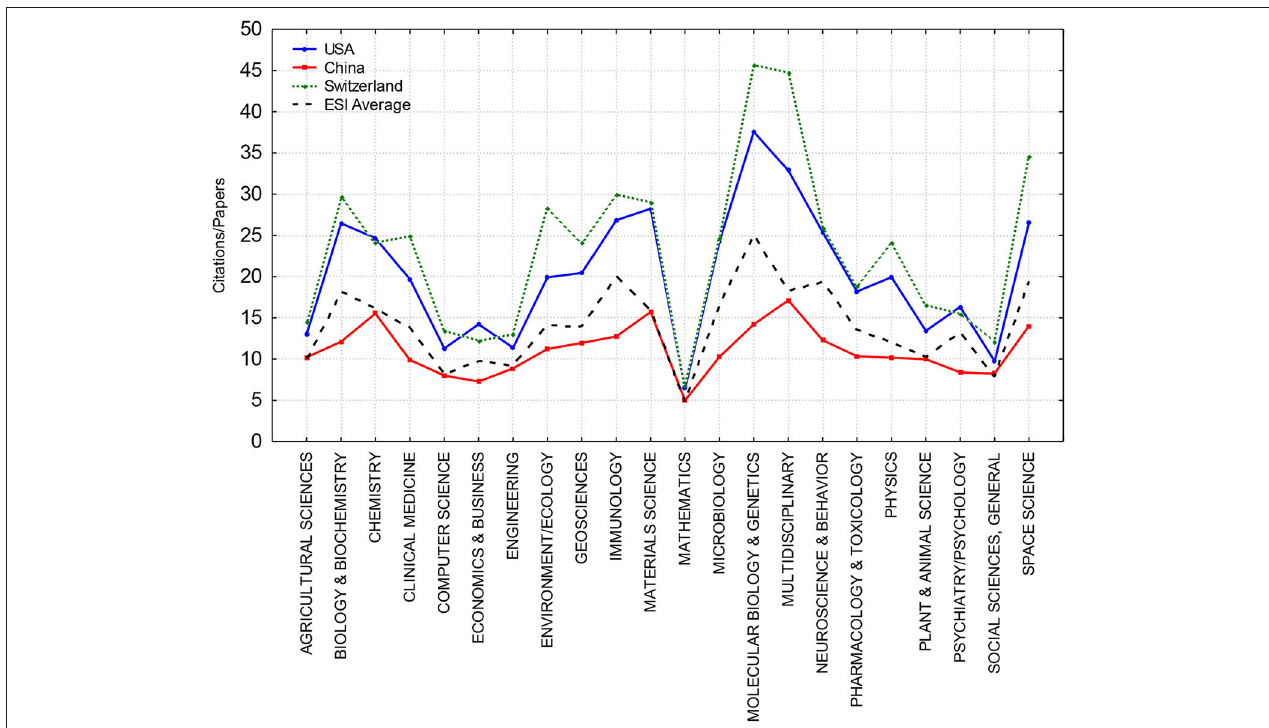
FIGURE 1 | The mean citation rates across 22 research fields for three countries, USA (blue), China (red), and Switzerland (green), compared with the ESI average (black broken